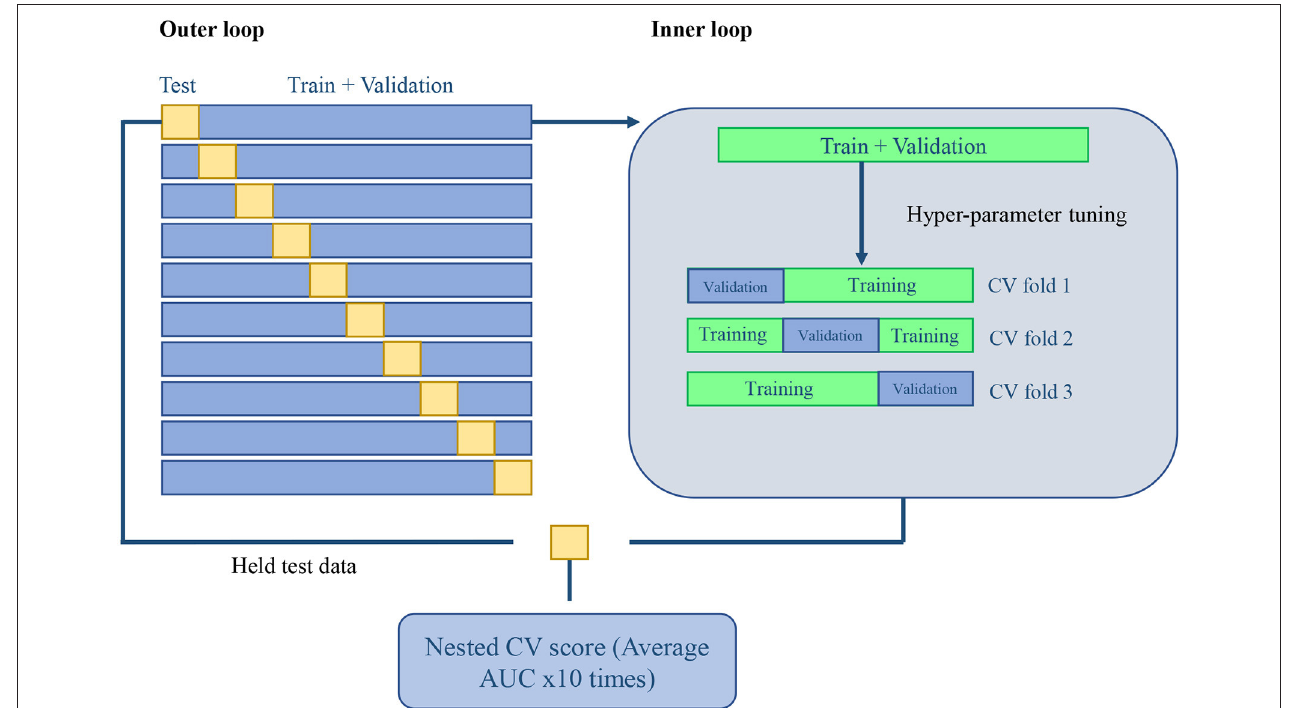
FIGURE 1 | Machine learning validation: 10-fold outer loop Nested CV and a three-fold CV inner loop scheme.